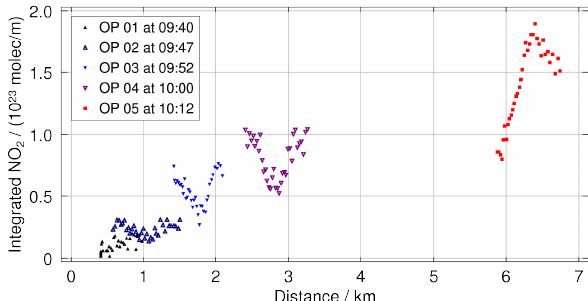
Figure 14. Integrated NO 2 amount across the plume from five in- dividual overpasses (OP) at different times and distances from the stack. Results are taken from the LOS35 evaluation; therefore, in total, 175 cross sections through the plume are included in this dia- gram.